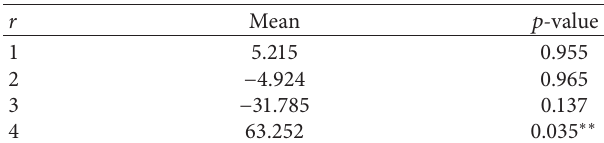
Table 4: The mean of the fine-to-coarse reconstruction as a function of index r